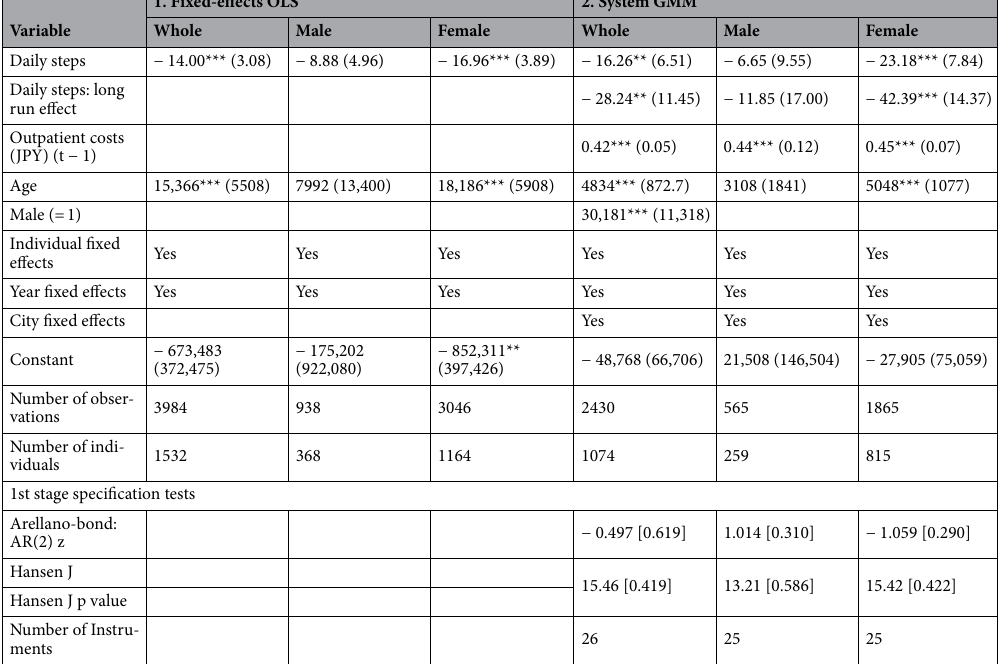
Table 2. Effects of daily step on healthcare costs: outpatient services. Robust standard errors in parentheses. ***p < 0.01, **p < 0.05; p values in brackets. The long-run effects of daily step on healthcare costs are calculated by the coefficient of daily steps divided by 1 minus the lagged coefficient of the dependent variable. OLS ordinary least squares, GMM generalized method of